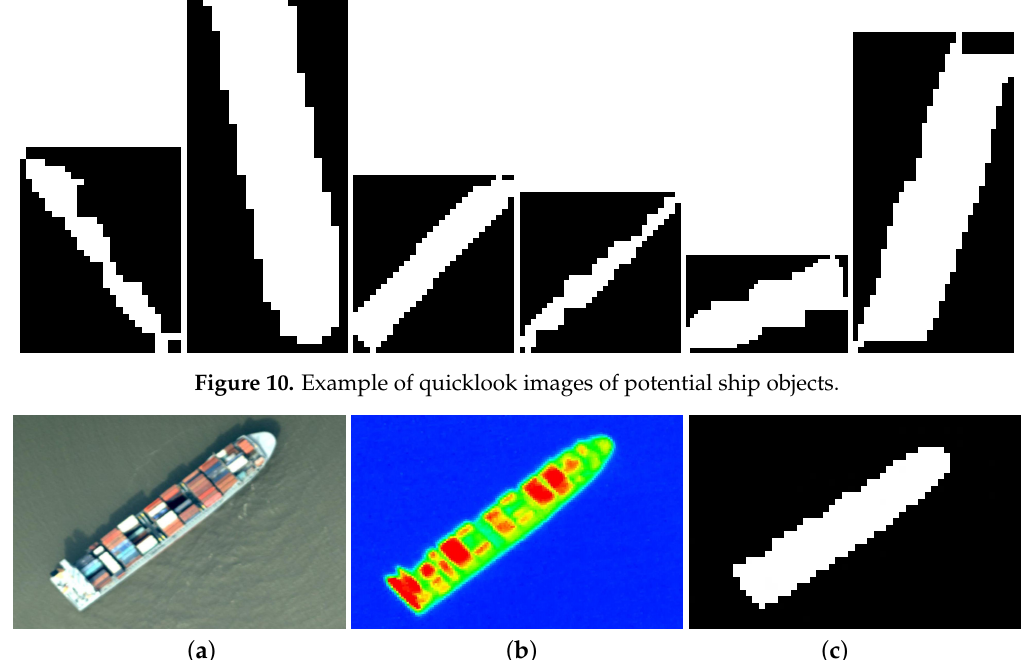
Figure 11. Ship detected by AMARO, 12th April 2018, 11:45am UTC, Mouth of the Elbe, Hamburg, Germany: ( a ) RGB image ( b ) thermal image ( c ) quicklook which was sent to ground from